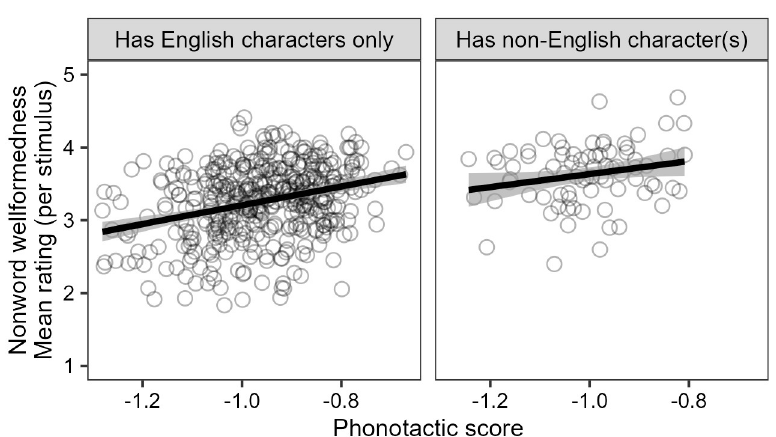
Fig 2. Summary of raw results from Experiment 2, showing participants’ mean wellformedness ratings for each nonword stimulus and their relation to phonotactic score, split based on whether or not the stimulus contains a non-English accented character. Points represent mean ratings for each nonword, and straight lines show correlations with phonotactic scores. In general, ratings increase with phonotactic score, and nonwords containing a non-English character are rated higher than those without any such